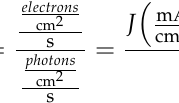
6 and PDDA/[Ni25/(PDDA